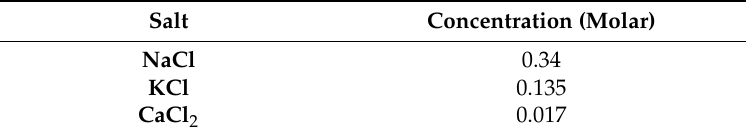
Table 1. Calculated salt concentrations for a crystalline rock mass at 995 m BGL [20].